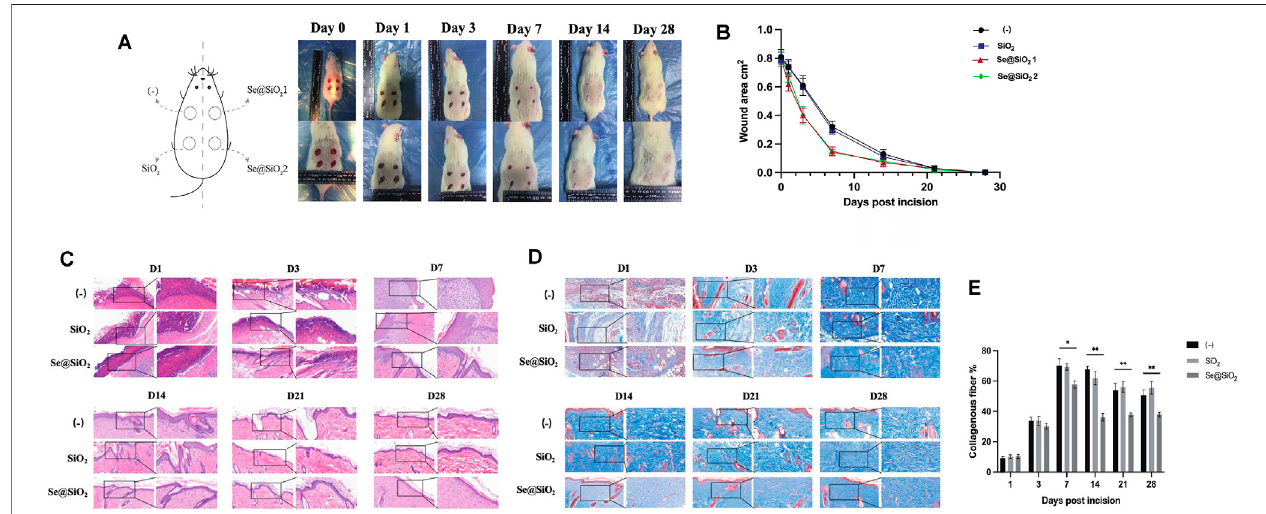
FIGURE2| Se@SiO 2 NPspromotetheprocess ofscarlesswoundhealing. (A) Establishment offull-thicknesswoundsonthebackofrats. (B) Wound closurerate of excisionalinjury. (C) H&E staining shows changes of dermal wound surface reconstruction in the Se@SiO 2 , SiO 2 and (-)groups at each time point (scale bars: 50 μ m) (200× and 400×). (D) Masson ’ s trichrome staining of wound tissues at each time point. (E) Density of collagen in the wound tissues based on Masson ’ s trichrome staining. * p < 0.05, ** p < 0.01 and *** p < 0.001. Abbreviations: H&E, hematoxylin and eosin.